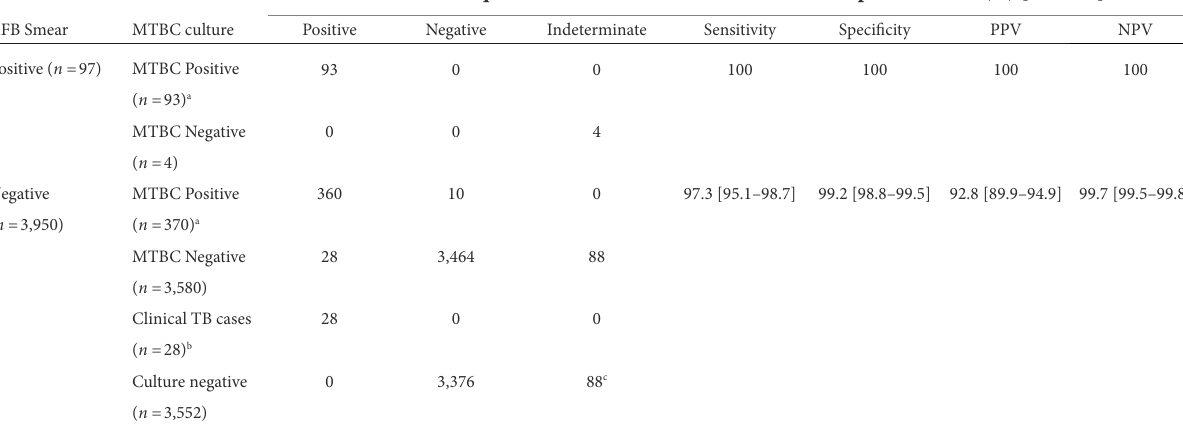
TABLE 2 Diagnostic performance of IS6110-qPCR among 4,047 respiratory specimens using cutoff Ct value at